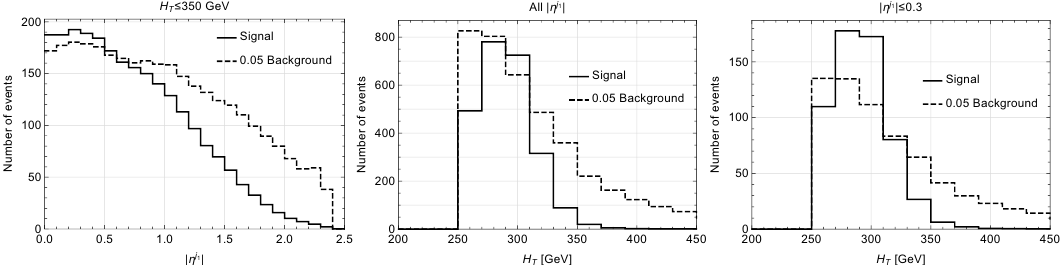
Figure 5 . Distributions of signal (solid) and our estimate of the pre-(cid:12)t systematic error (5% of the background events) in the N j = 1, N b = 0 SRs of CMS036. Left: distribution with respect to jet j (cid:17) j . Center: distribution with respect to H T without a cut on j (cid:17) j . Right: distribution with respect to H T requiring jet j (cid:17) j < 0 :